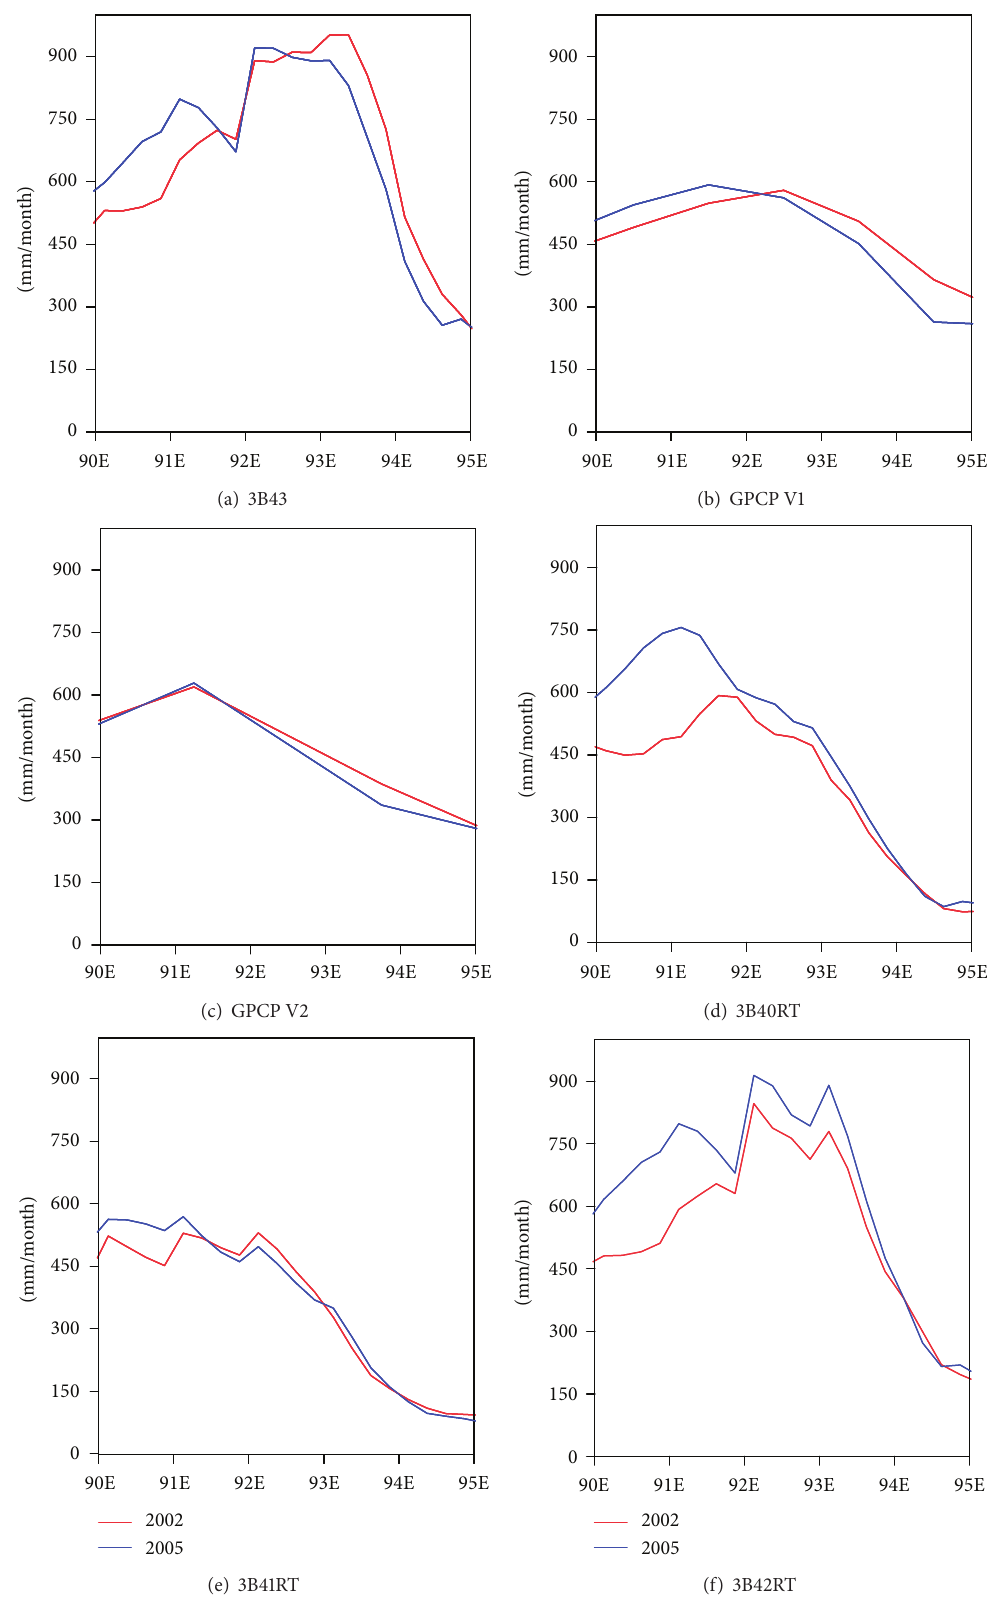
Figure 4: JJA mean precipitation (mm month −1 ) averaged within latitudinal band of 19–21 ∘ N in 2002 and